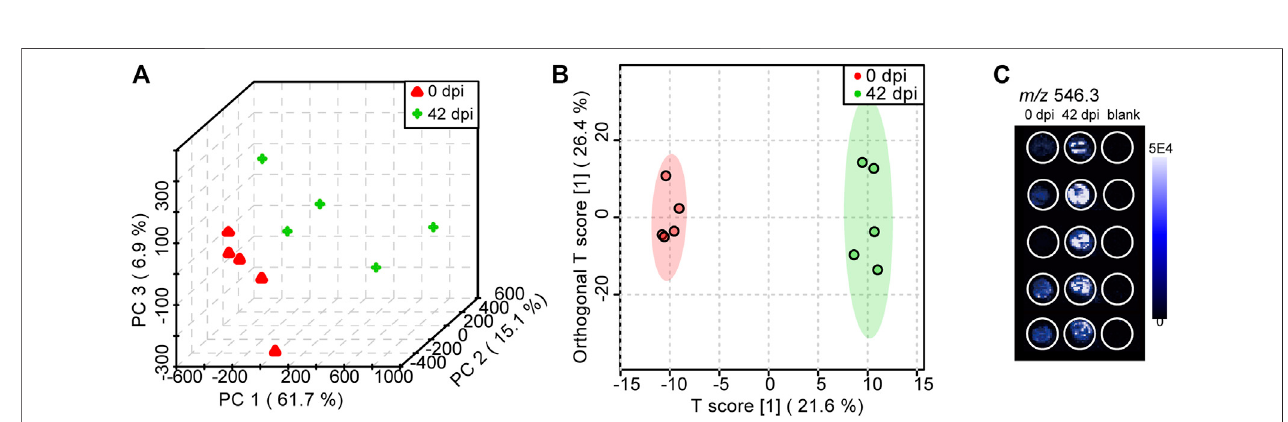
FIGURE5| PCA (A) andOPLS-DA (B) scoreplotsobtainedfromthe Schistosomajaponicum ( S.japonicum )-infectedgroup(42dpi)andcontrolgroup(0dpi)using DPS sampling with DESI-MS analysis (C) A DESI-MS image of the concentration status of LysoPC (22:3) ( m/z 546.3) in different